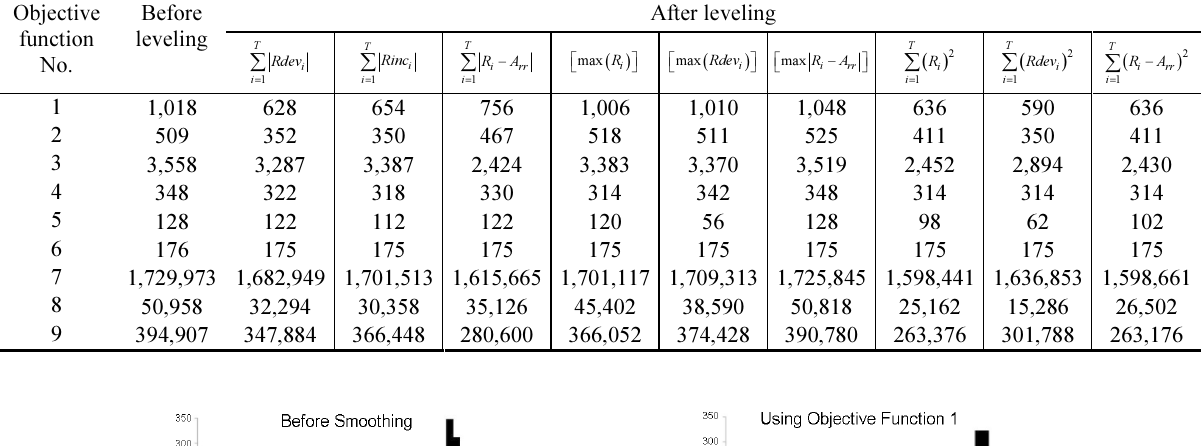
Table 3. Results for different objective functions after resource levelling Objective